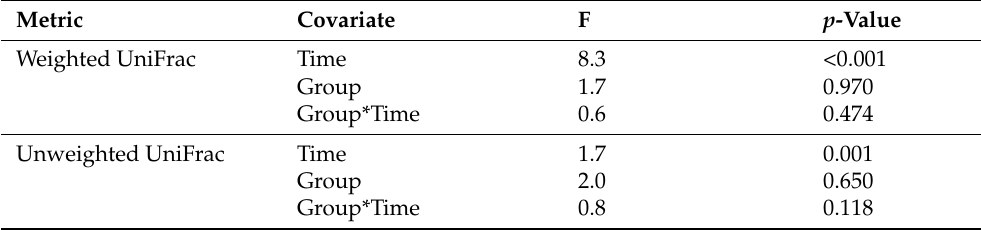
Table 2. Results of longitudinal permutational ANOVA models to assess whether changes in the overall gut microbiota composition over the first three months of the intervention differed by group (DCR versus IMF). Quantitative (weighted UniFrac) and qualitative (unweighted UniFrac) indices of beta-diversity were used as summary measures of the gut microbiota composition among n = 111 samples from 59 individuals (47 samples from 25 DCR / 64 samples from 34 IMF). There were no significant differences between intervention groups in the change in beta-diversity over